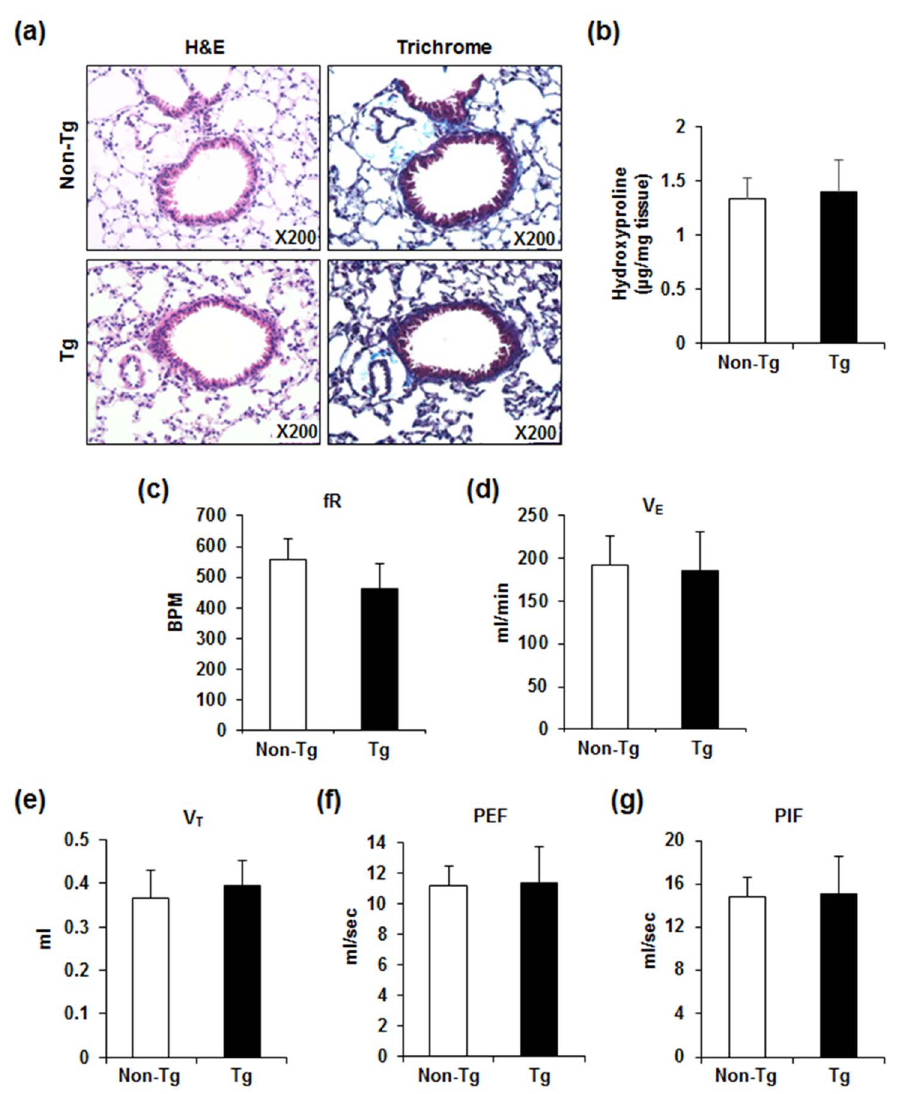
Figure 2. Retnla overexpression did not alter lung histology or function under normal conditions. (a) Representative lung sections from non-Tg (top row) and Retnla -Tg (bottom row) mice stained with hematoxylin and eosin (left panel) or trichrome (right panel) (collagen is stained blue). Inset: original magnification, 200 6 . There was no significant inflammatory change in hematoxylin and eosin staining, and collagen content (blue in trichrome staining) was not changed in Retnla -Tg mice. (b) Fibrosis was assessed by the measurement of hydroxyproline in the lungs from non-Tg and Retnla -Tg mice (n 5 8 for non-Tg, n 5 5 for Retnla -Tg). (c–g) Analysis of pulmonary functional parameters including (c) respiratory frequency (fR, BPM indicates breaths per minute), (d) minute ventilation (V E ), (e) tidal volume (V T ), (f) peak expiratory flow (PEF), and (g) peak inspiratory flow (PIF) were measured using whole-body plethysmography (n 5 7 to 8 per group). There were no significant changes in pulmonary function of Retnla -Tg mice compared to those of non-Tg mice. Data are presented as mean ¡ SD. Statistical analysis was performed with the Mann-Whitney U -test.